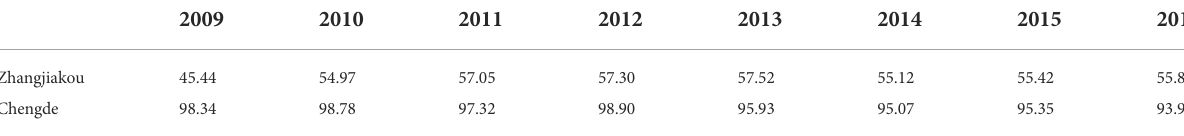
TABLE 1 The occupancy rate of natural capital fl ow of cultivated land in Zhangjiakou and